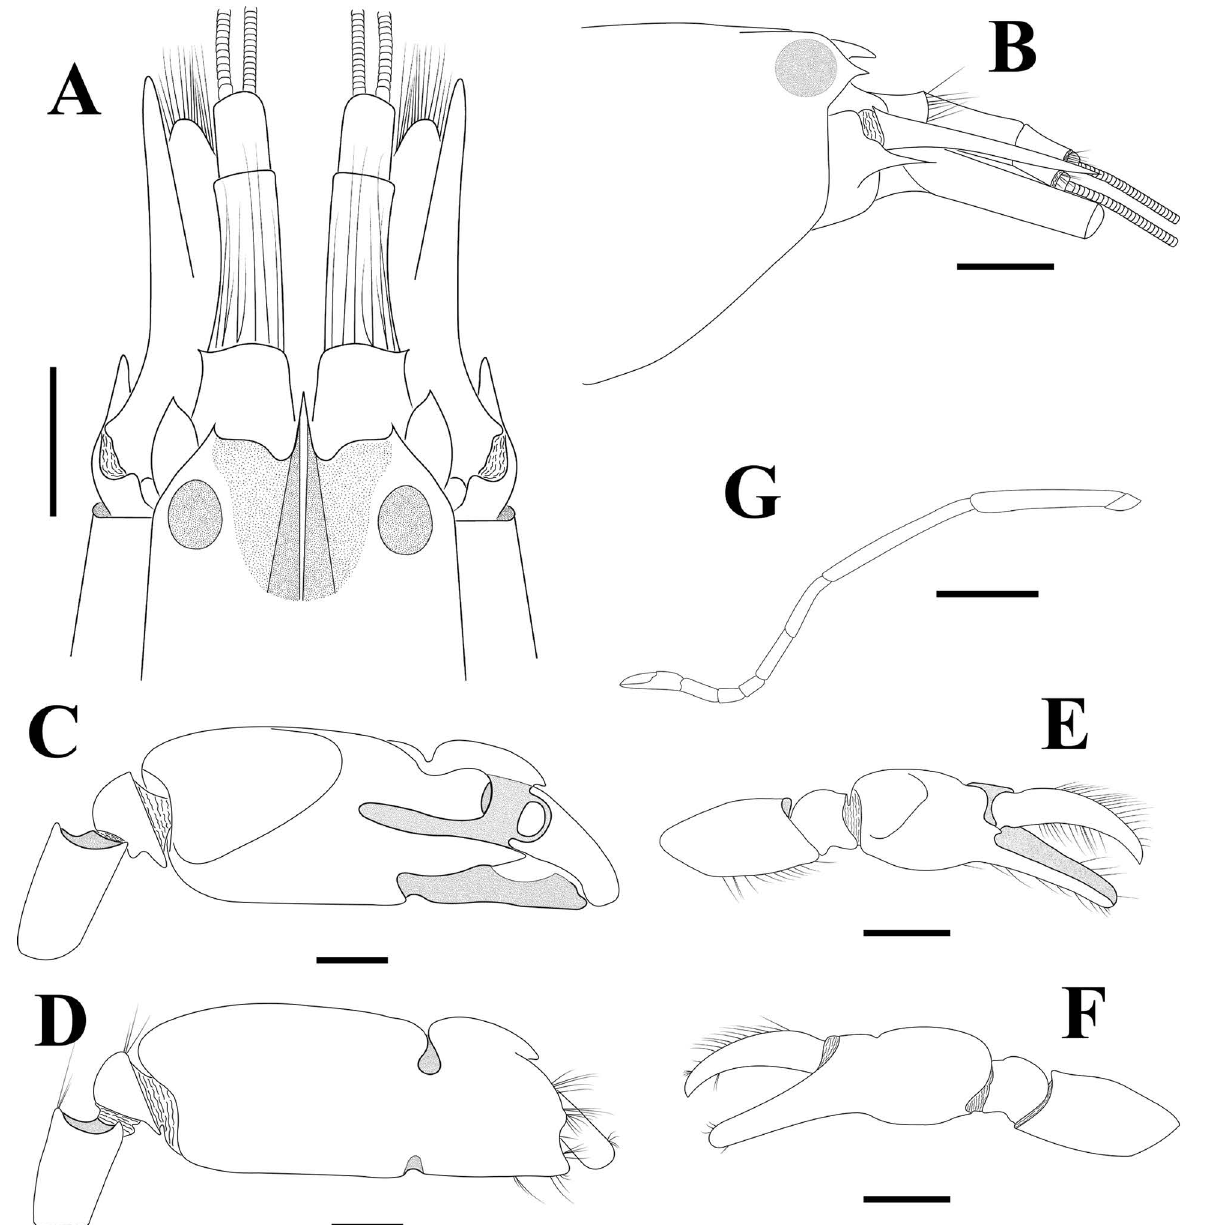
Figure 1. Alpheus peasei (Armstrong, 1940). Female from Campos Basin, Rio de Janeiro, Brazil (MZUSP 25346). A, frontal region and cephalic appendages, dorsal view (setae partially omitted); B, same, lateral view (setae partially omitted); C, major cheliped, lateral view (setae omitted); D, major cheliped, mesial view; E, minor cheliped, lateral view; F, minor cheliped, mesial view; G, second pereiopod. Scale bars = 1